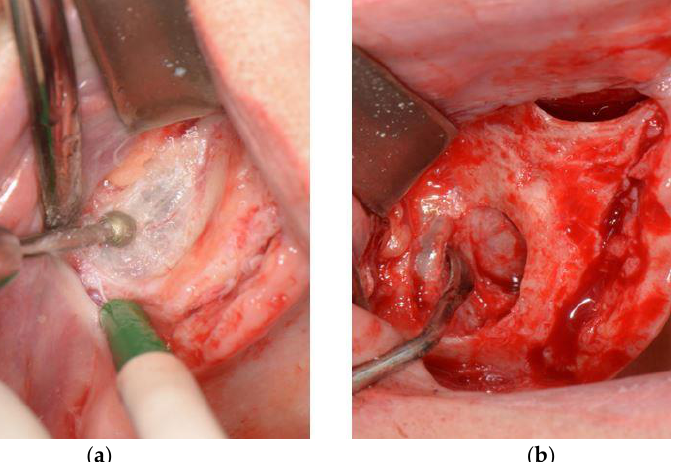
Figure 2. ( a ) Preparation of access window on the vestibular bone; ( b ) Detachment and elevation of the nasal mucosa.